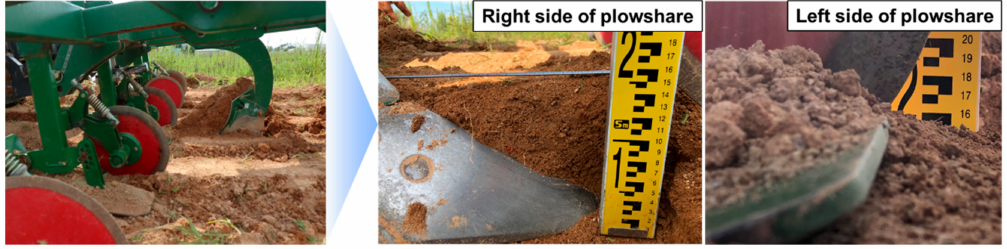
Figure 9. Manually measured tillage depth in test